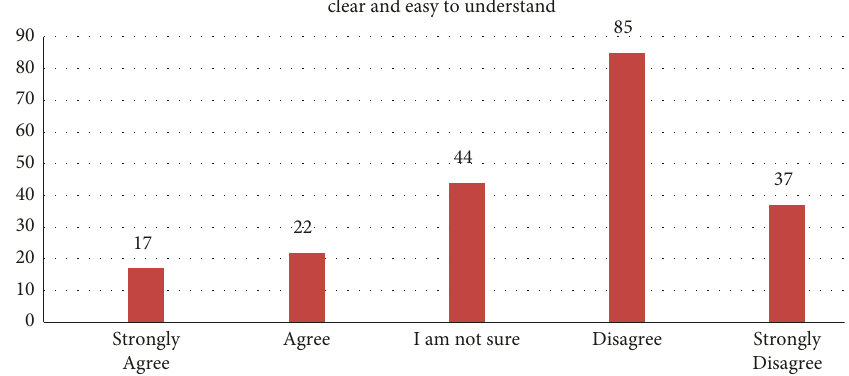
Figure 1: Participants’ responses regarding the language clarity of the Arabic version of Amazon.sa.